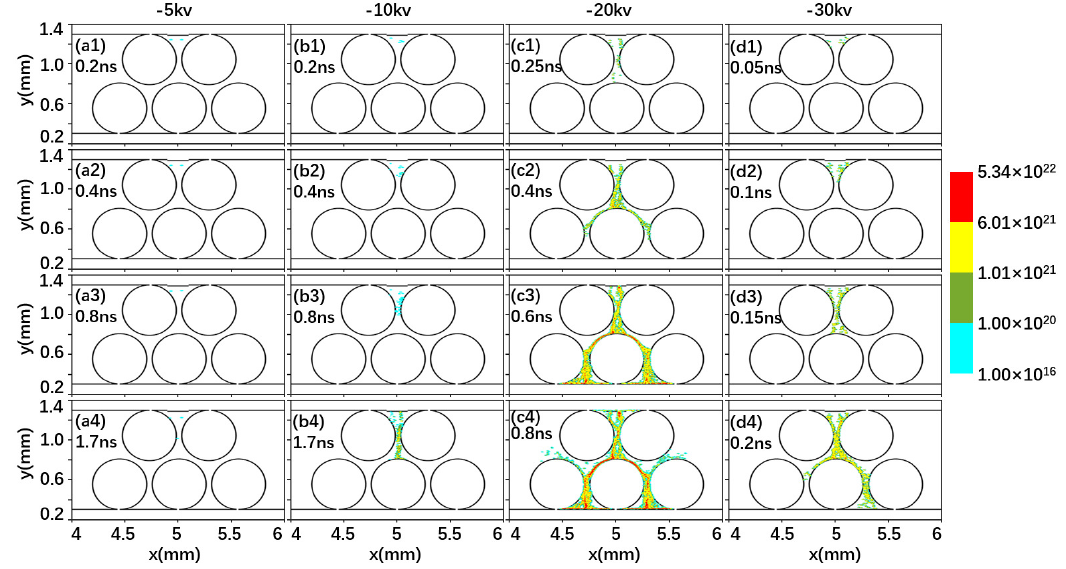
Figure 3. O + ion density (m − 3 ) for the same conditions as in Figure 2